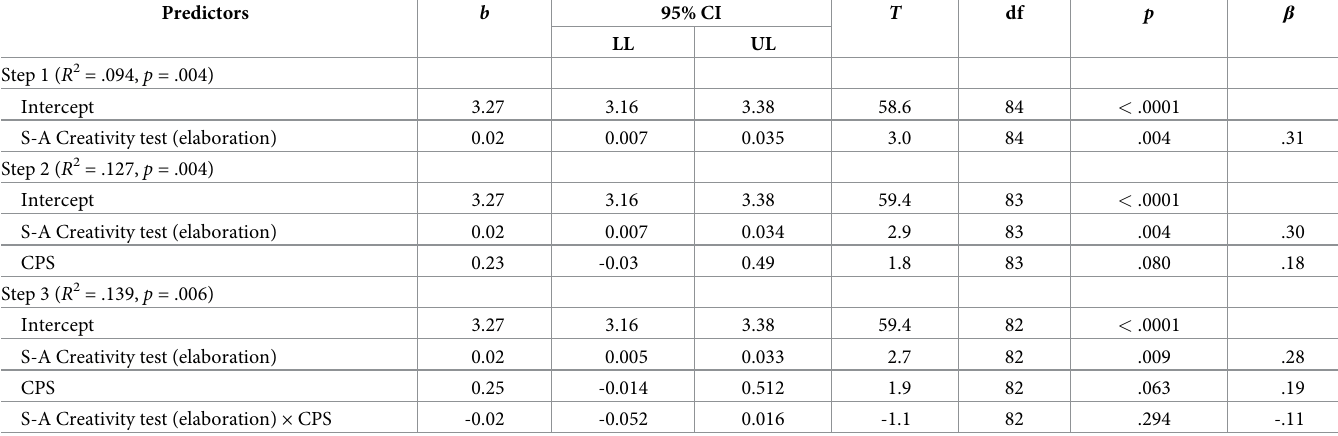
Table 5. Results of multiple regression analysis in the effect of elaboration with creative production score as the objective variable. Predictors